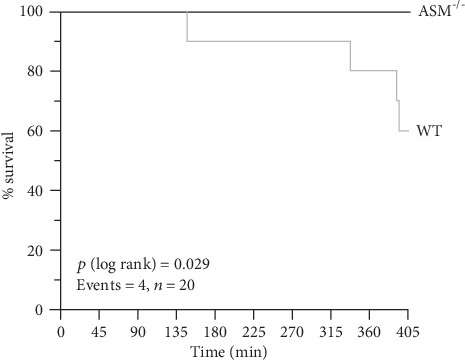
Survival. Survival was compared by univariate Kaplan-Meier analysis in TNF-treated WT and ASM−/− mice. Four WT mice died during the experiment, whereas all TNF-treated ASM−/− mice survived (p < 0.05, n = 10 per group).